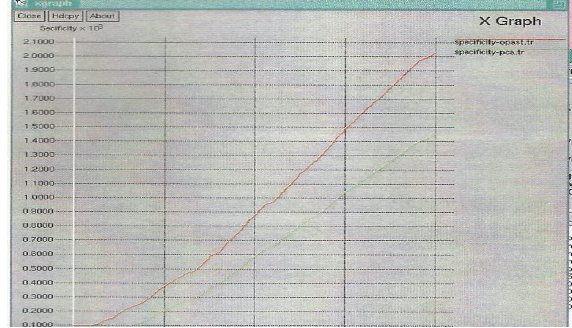
Figure 7. Throughput of the Network